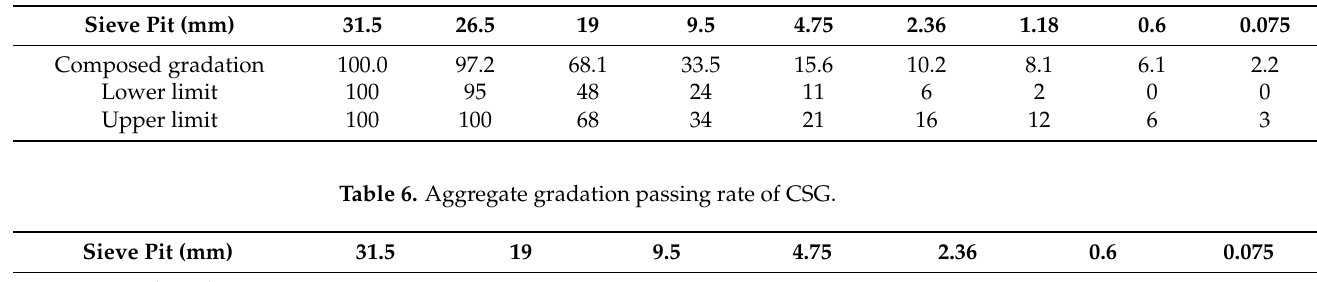
Table 5. Aggregate gradation passing rate of LFSG.